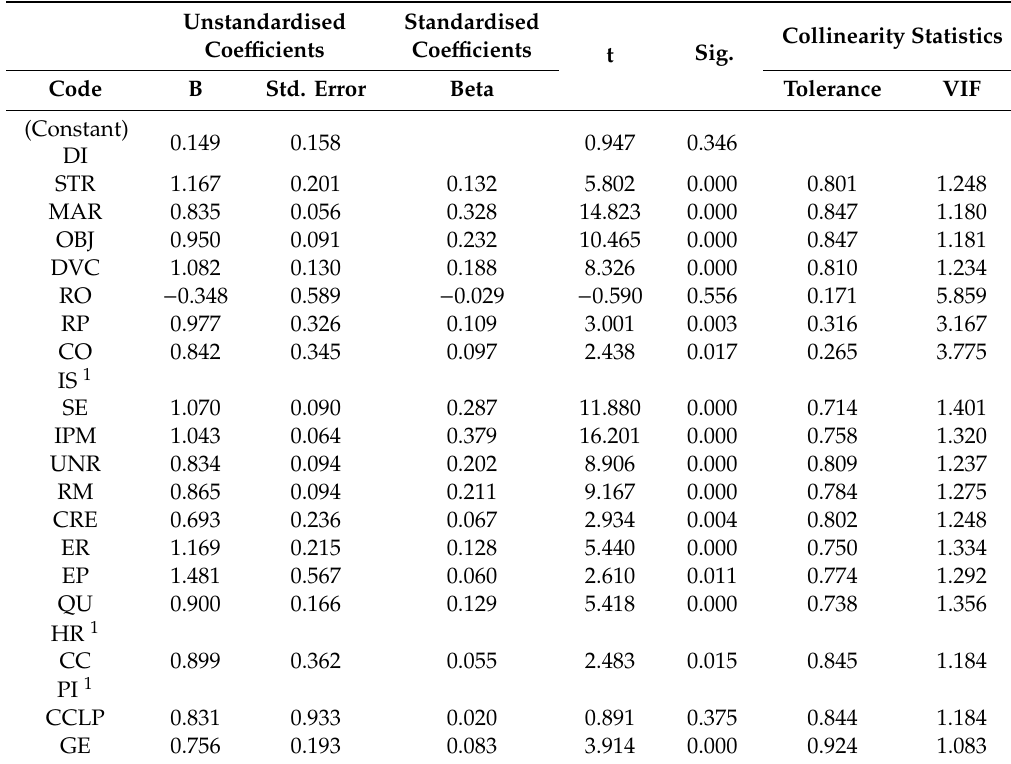
Table 5. Regression Summary: Coe ffi cients and